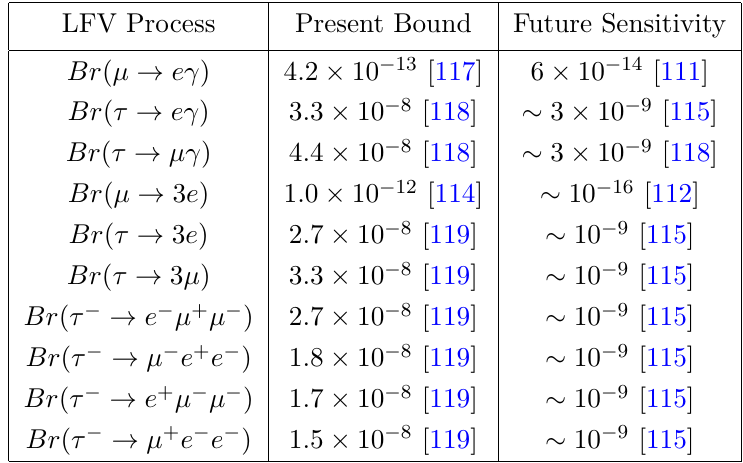
Table 3 . Current Experimental bounds and future sensitivities for the LFV